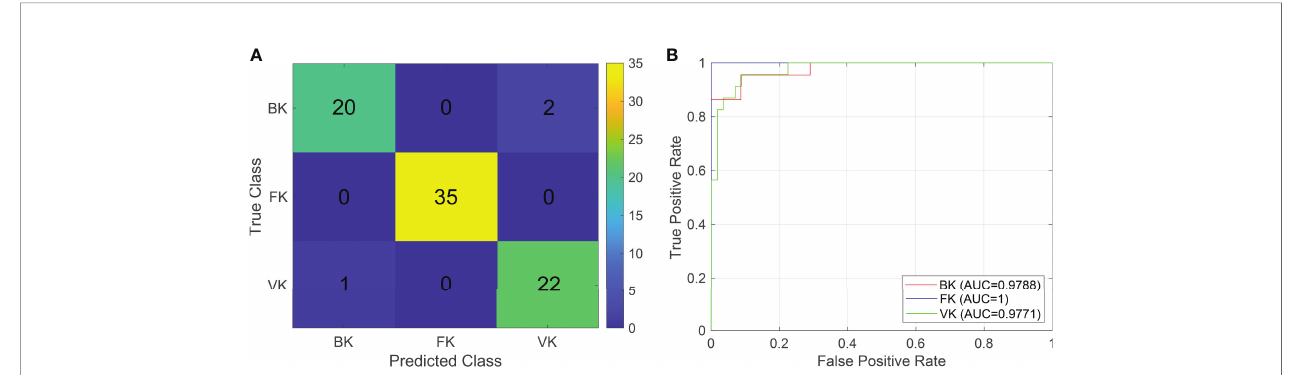
FIGURE 3 | The classi fi er based on the relative composition of conjunctival bacterial microbiota can effectively distinguish various types of microbial keratitis. For the confusion matrix (A) , a number in a grid denotes how many actual cases from the ordinate are judged as the abscissa. For the ROC curve (B) , the AUC re fl ects the performance of the established classi fi er for distinguishing various types of microbial keratitis. (CG, control group - healthy eyes; BK, bacterial keratitis; FK, fungal keratitis; VK, viral keratitis; AUC, area under the ROC